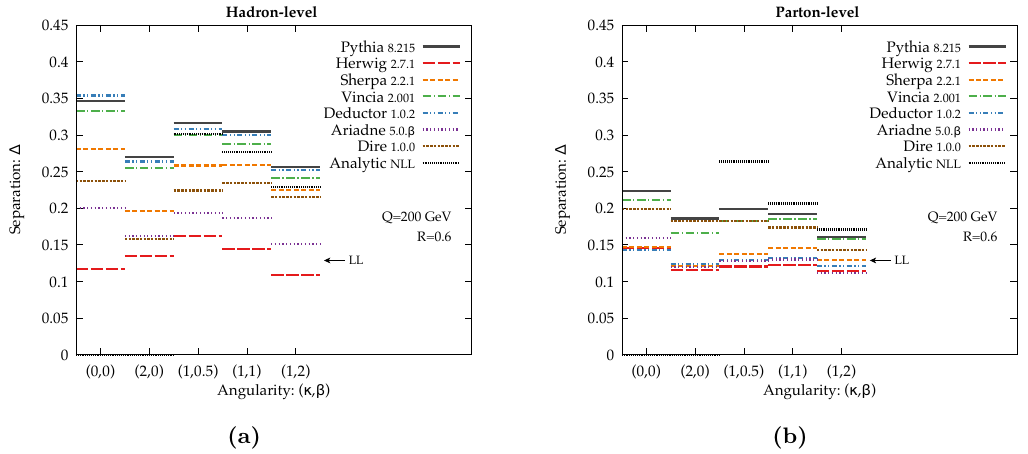
Figure 7. Classi(cid:12)er separation (cid:1) for the (cid:12)ve benchmark angularities in eq. (3.6), determined from the various generators at (a) hadron level and (b) parton level. The (cid:12)rst two columns correspond to IRC-unsafe distributions (multiplicity and p D ), while the last three columns are the IRC-safe T angularities. The LHA (i.e. (cid:20) = 1, (cid:12) = 1 = 2) is shown in the middle column. Results in terms of ROC values appear in the source (cid:12)les as supplementary material of this paper, for this and subsequent plots. The label \LL" indicates the value from eq. (4.9) predicted by Casimir scaling. where (cid:11) s 0 is the default value of the strong coupling, which is di(cid:11)erent between the